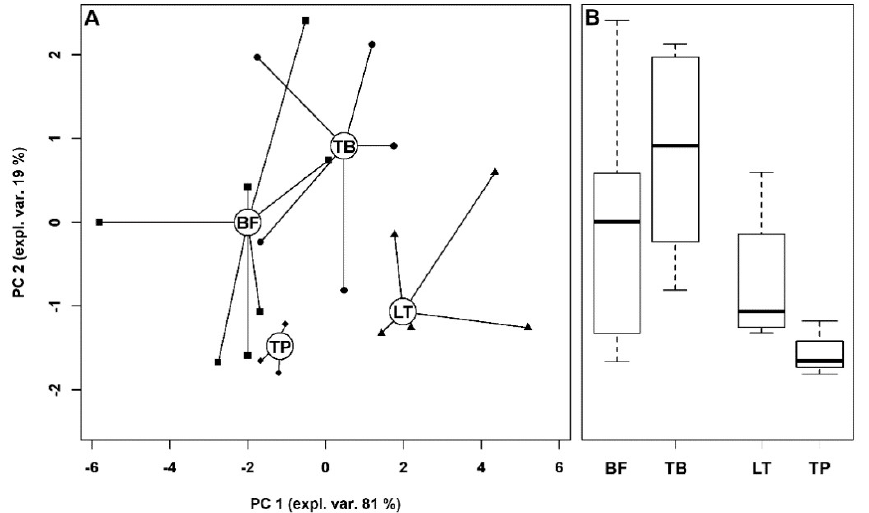
Figure 3. ( A ) Scoreplot of the rPCA model described in Figure 2, where TP samples have been projected. The wide, empty circles represent the median of the samples from the various types of muscles. ( B ) Boxplots summarizing the samples’ positions along PC 2.